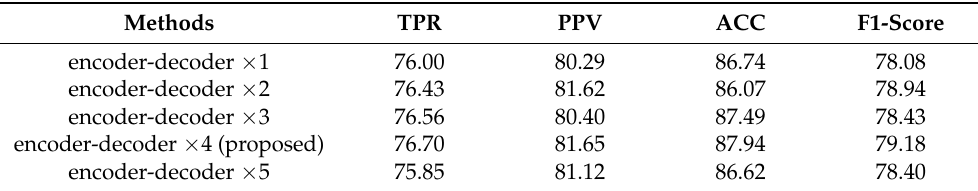
Table 14. Comparison of accuracies by the proposed PI-GAN generator and variants of generators in the Fruits-360 training set of 50%.